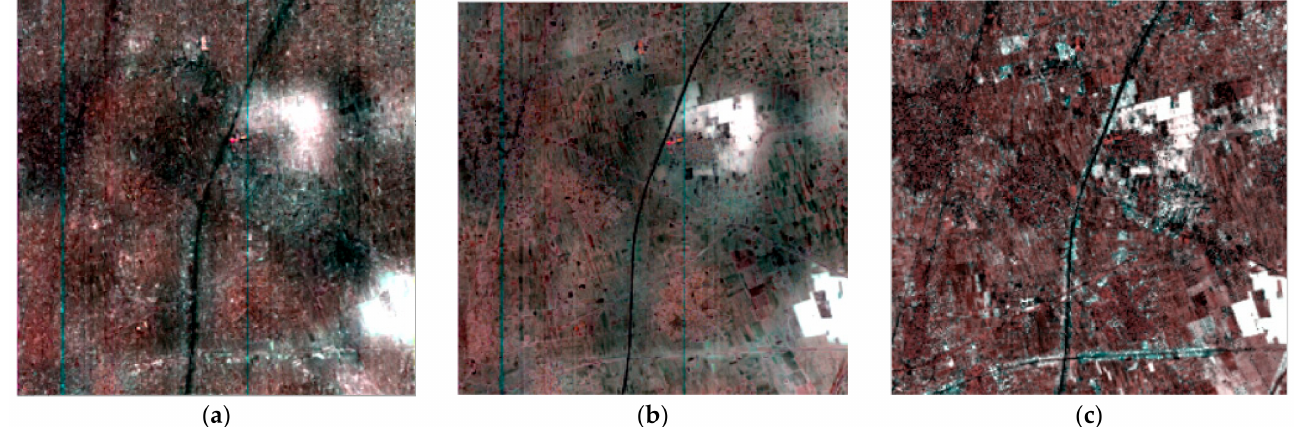
Figure 22. Different mode of up-sampling for the Baiyangdian dataset. ( a ) Nearest, ( b ) bilinear, ( c ) bicubic.